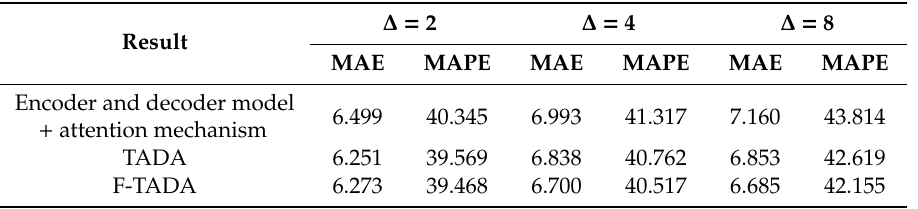
Table 1. Result of data set 1.